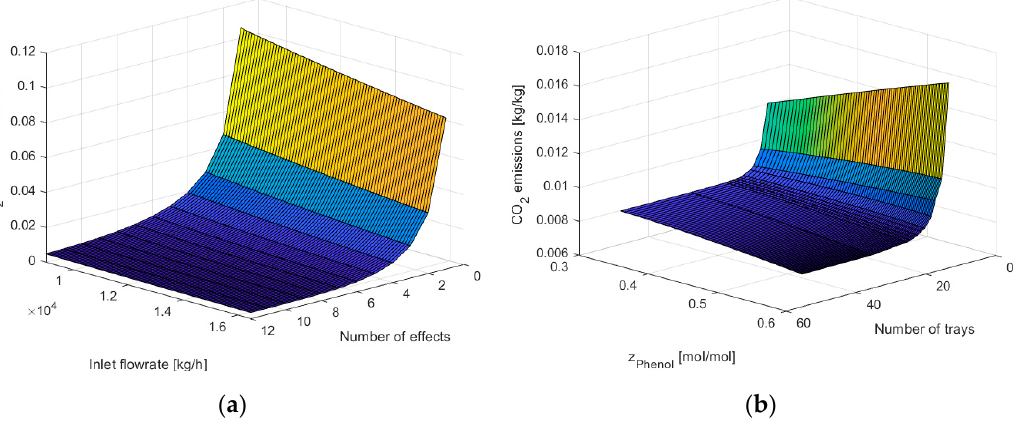
Figure 10. CO 2 emissions—sensitivity: ( a ) multiple-effect evaporator; ( b ) distillation